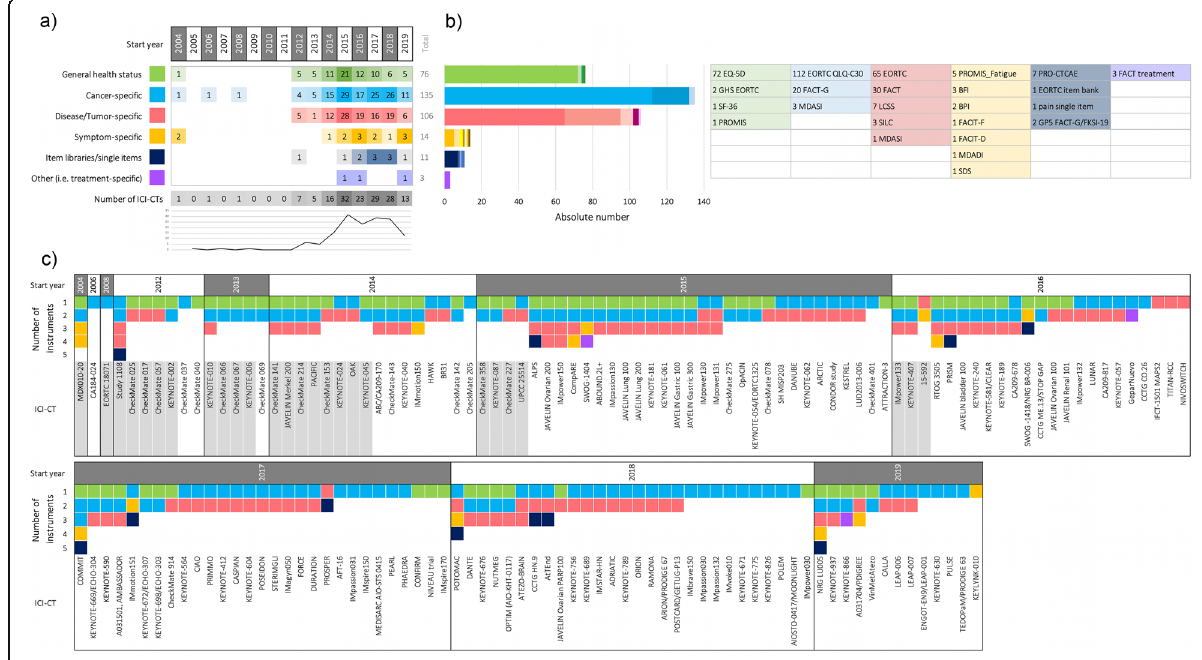
Fig. 2 Frequency of use and combination of PRO instruments in ICI-CTs ( n = 156). a Number of PRO instruments divided into categories and start year of the ICI-CTs. Green: general health status; Blue: cancer-specific; Red: disease/tumor-specific; Yellow: symptom-specific; Dark blue: items libraries/single items; Purple: other (e.g. treatment-specific). b Absolute number of instruments across all ICI-CTs divided per category. The table shows the different instruments per category. c Number and combination of PRO instruments per ICI-CT per year of start of the trial. For FACT questionnaires that include core domains of the FACT-G, both cancer-specific and disease specific have been depicted (see Table S4 for more detail). For ICI-CTs colored in light grey PRO results have been published ( n =